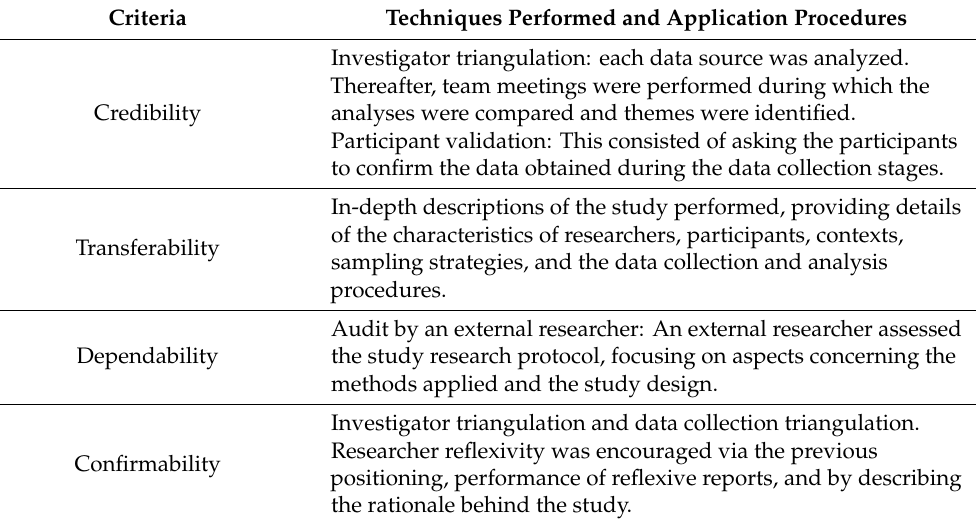
Table 4. Quality